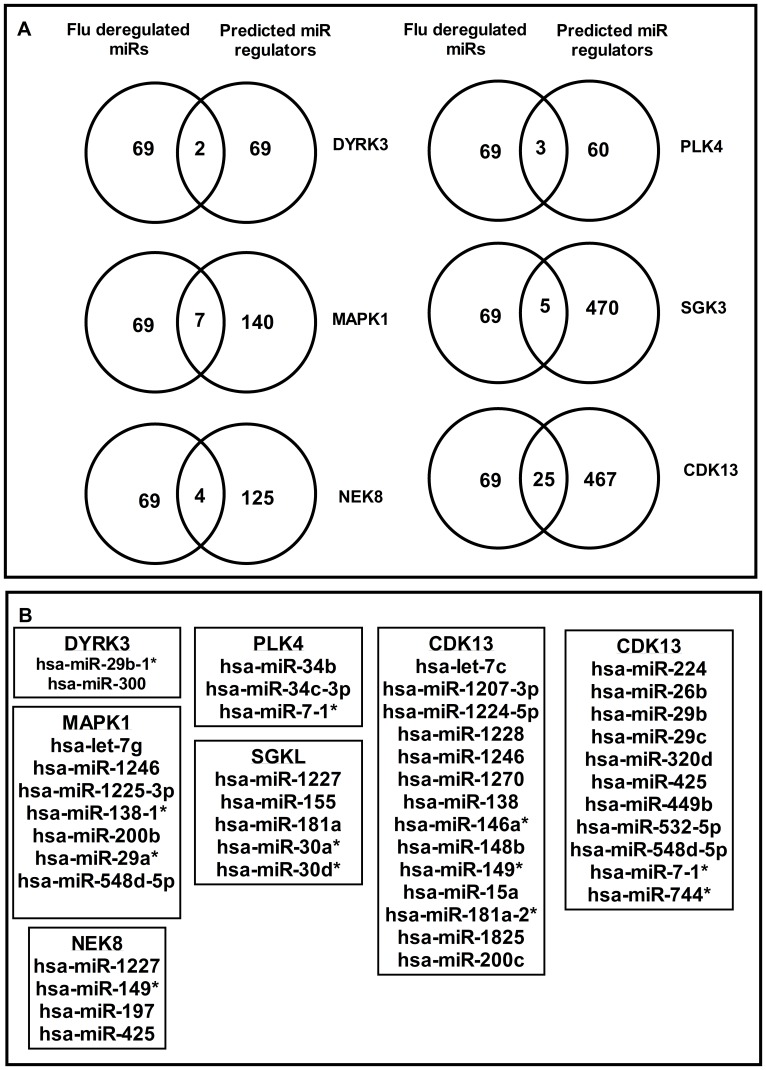
Identifying miRNA regulators of HPKs important for influenza replication.(A) Venn diagrams showing miRNAs common to computationally predicted miRNA regulators and influenza deregulated miRNAs. (B) miRNAs that are shared between computationally predicted HPK regulators and miRNAs deregulated during influenza infection.